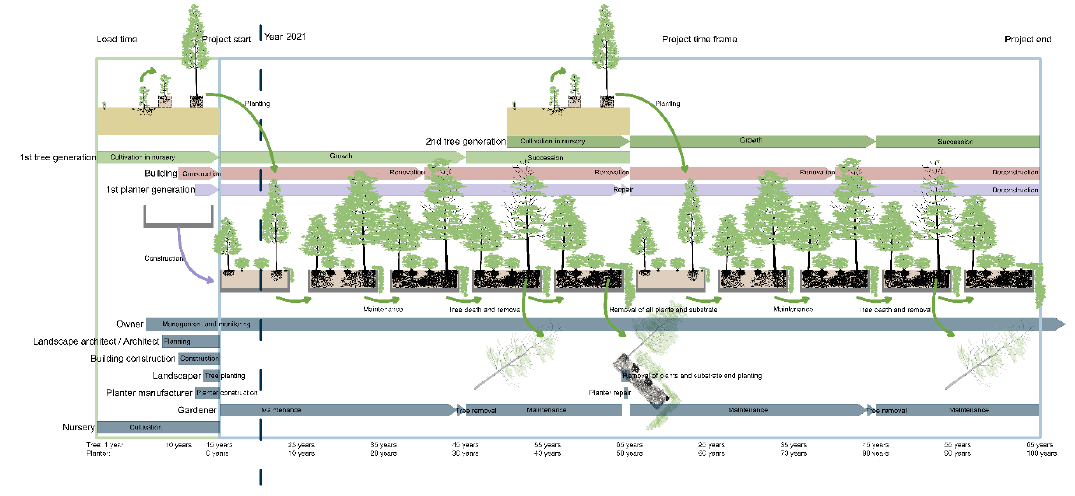
Figure 8. Time diagram of “Bosco Verticale”.